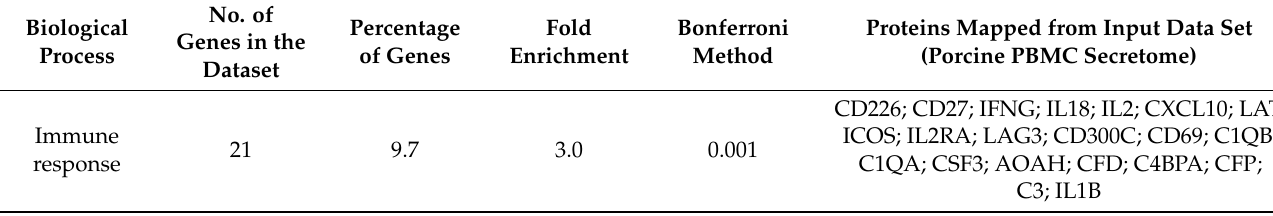
Table 3. Significantly enriched biological process in secretome of BanLec stimulated porcine PBMC.